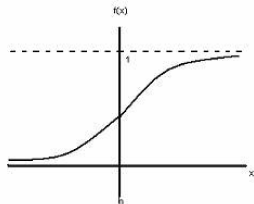
Fig. 2 Activation Function of Binary